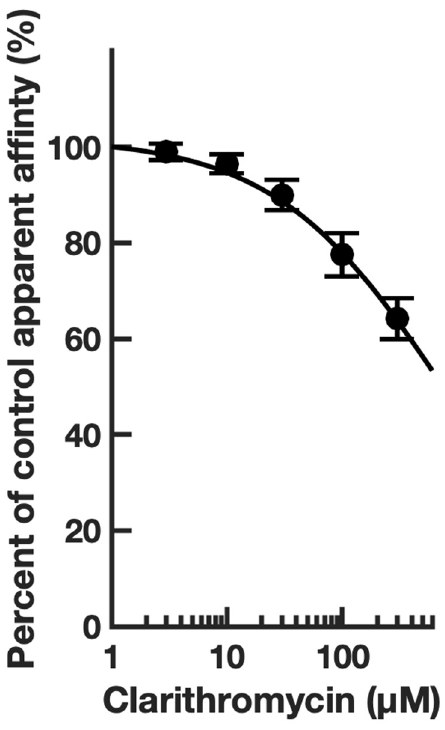
Figure 10. Increasing clarithromycin concentration raises the GABA EC 50 exponentially. The GABA EC 50 was determined at 6 different clarithromycin concentrations (0–300 µ M). The increase in EC 50 for each clarithromycin concentration is plotted as a decrease in apparent affinity.